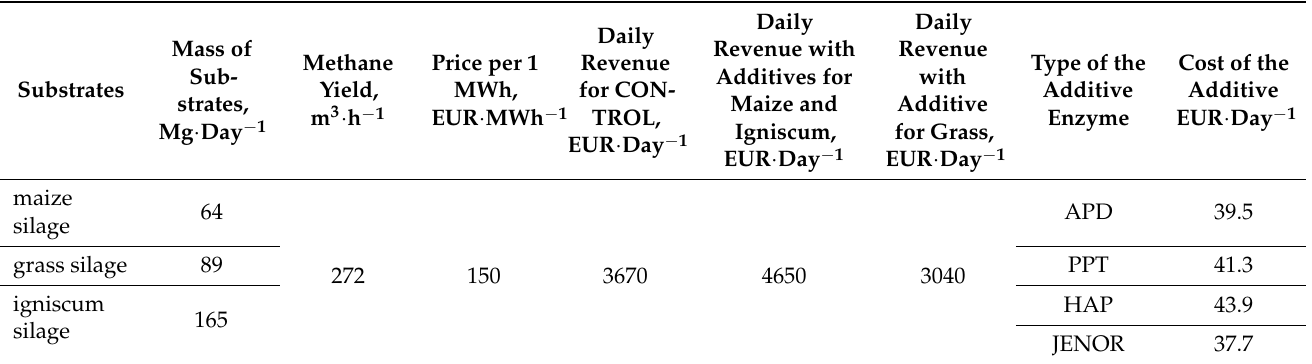
Table 4. Estimated costs and revenues for the use of different additives and silages in a 1 MW capacity biogas